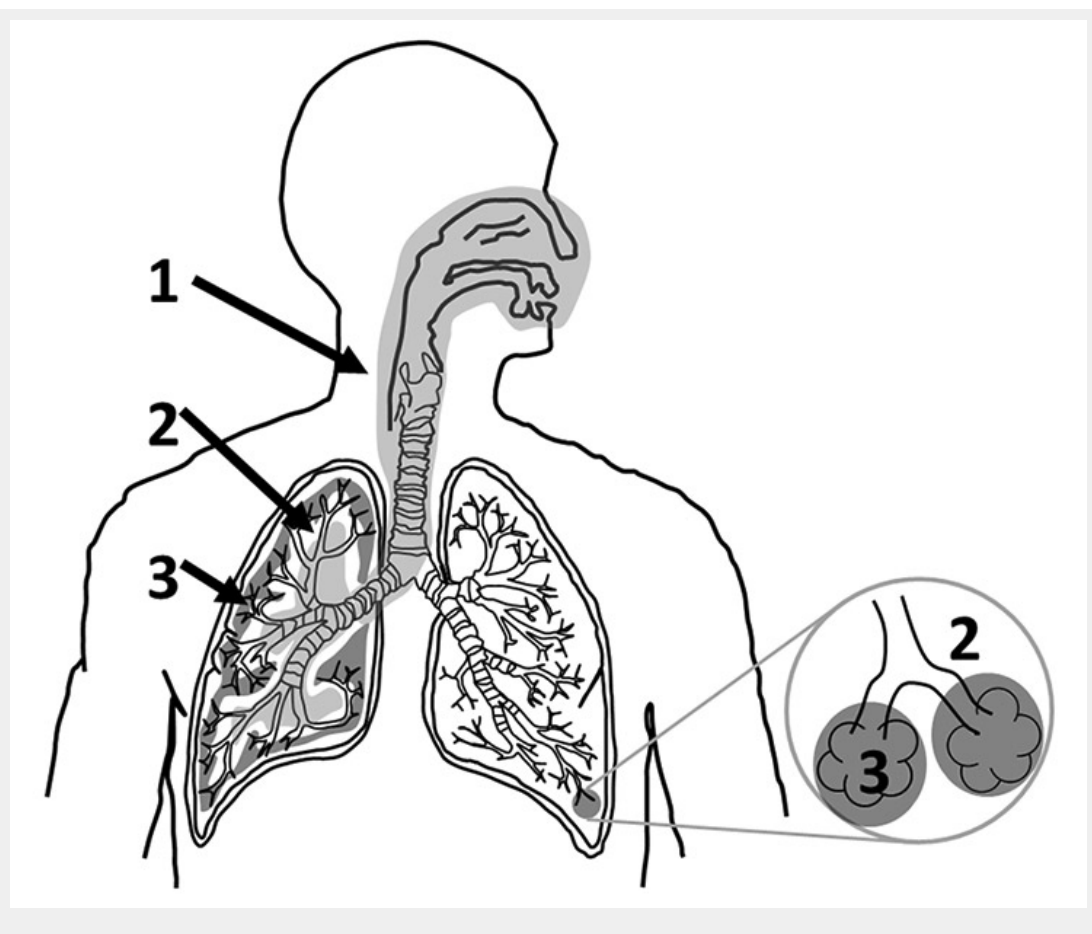
The human respiratory tract can be subdivided into three main structurally and functionally distinct areas. The air enters the thoracic region and continues to the tracheobronchiolar region (1, light grey). From there the air is conducted to the proximal part of the alveolar-interstitial region (2, white) before it reaches the distal part of the alveolar-interstitial region (3, dark